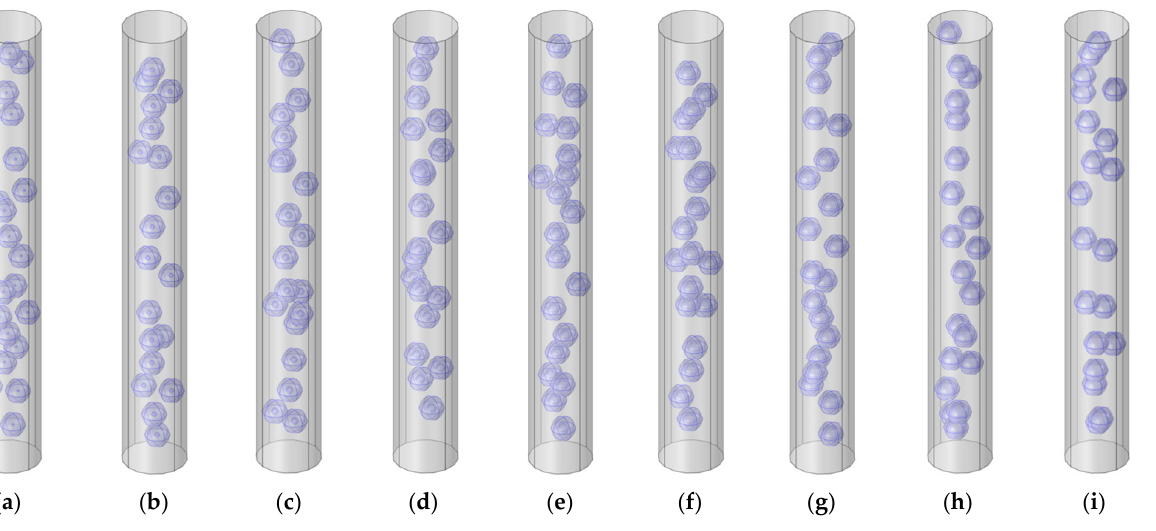
Figure 10. Acoustic finite element simulation models of the composite rubber reinforced with the HGM for the various hollow ratio of the HGM. ( a ) 10%; ( b ) 20%; ( c ) 30%; ( d ) 40%; ( e ) 50%; ( f ) 60%; ( g ) 70%; ( h ) 80%; ( i ) 90%. Table 5. The summarized STL data with the various hollow ratio of the HGM.